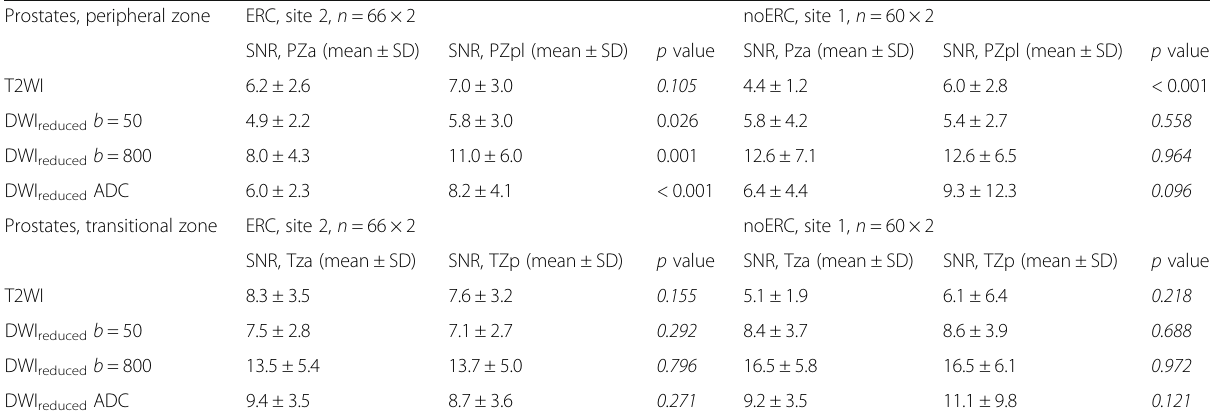
Table 3 Signal-to-noise ratio in human prostates with benign hyperplasia examined with endorectal coil filled with air in site 2 ( n = 66 corresponding regions of interests, in anterior and posterior locations, respectively), and without endorectal coil at site 1 ( n = 60 corresponding regions of interest, in anterior and posterior locations, respectively) Prostates, peripheral zone ERC, site 2, n = 66 × 2 noERC, site 1, n = 60 ×